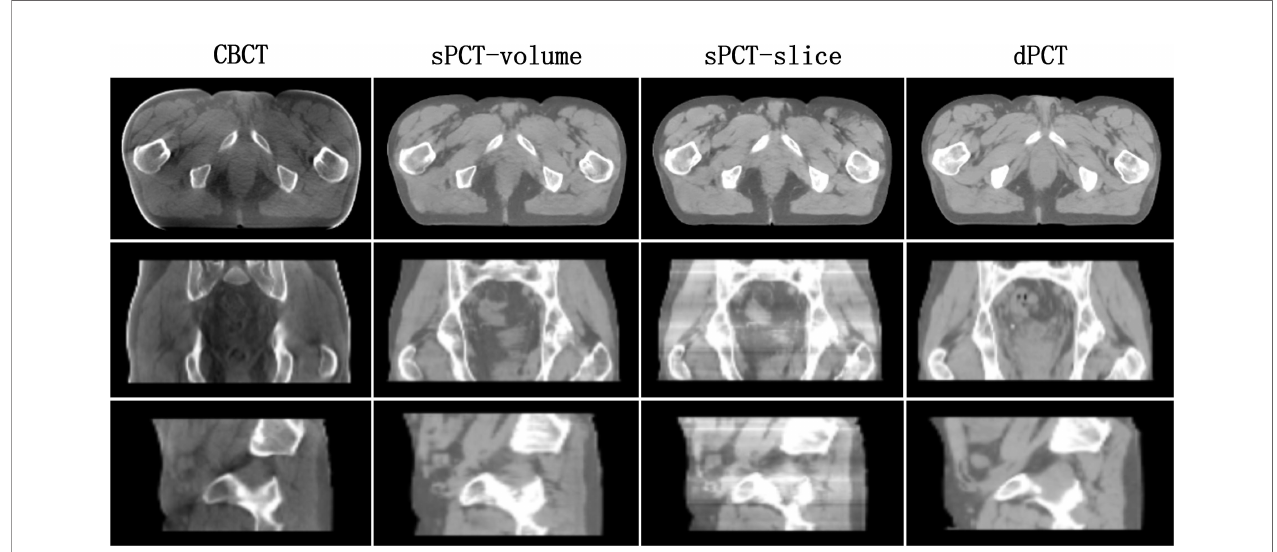
FIGURE 11 | Effect of different normalization method on sPCT. Each column from left to right represents CBCT, sPCT (3D), sPCT (2D), and dPCT respectively. The top, middle, and bottom rows represent axial, coronal, and sagittal images respectively. Strip artifacts were found in the coronal and sagittal planes of 2D sPCT images. The display window is (700, 1300)